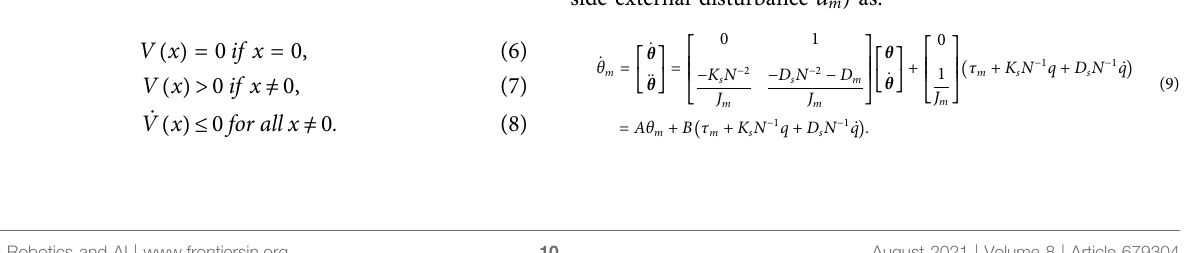
Frontiers in Robotics and AI |